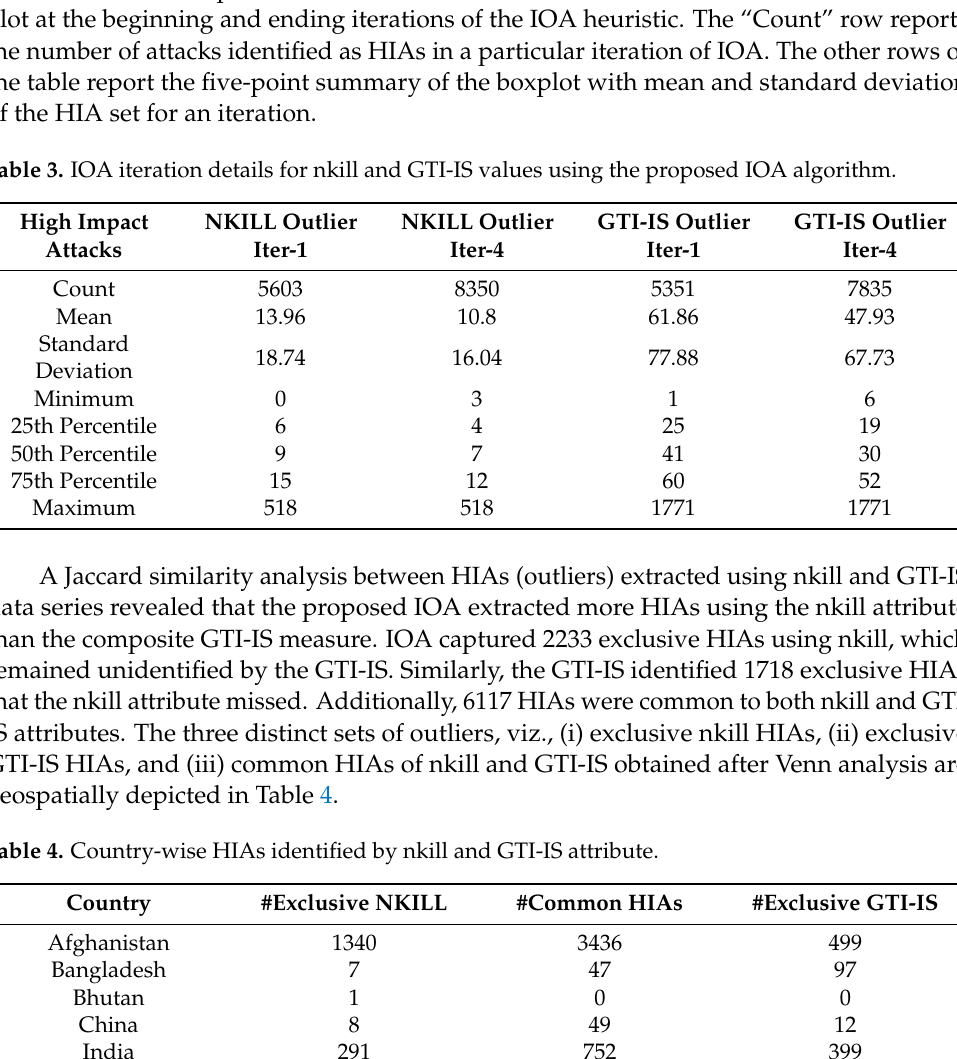
Table 2. Category levels for property damage attributed to the terrorism data of India and its neighbors. Damage Code Codebook